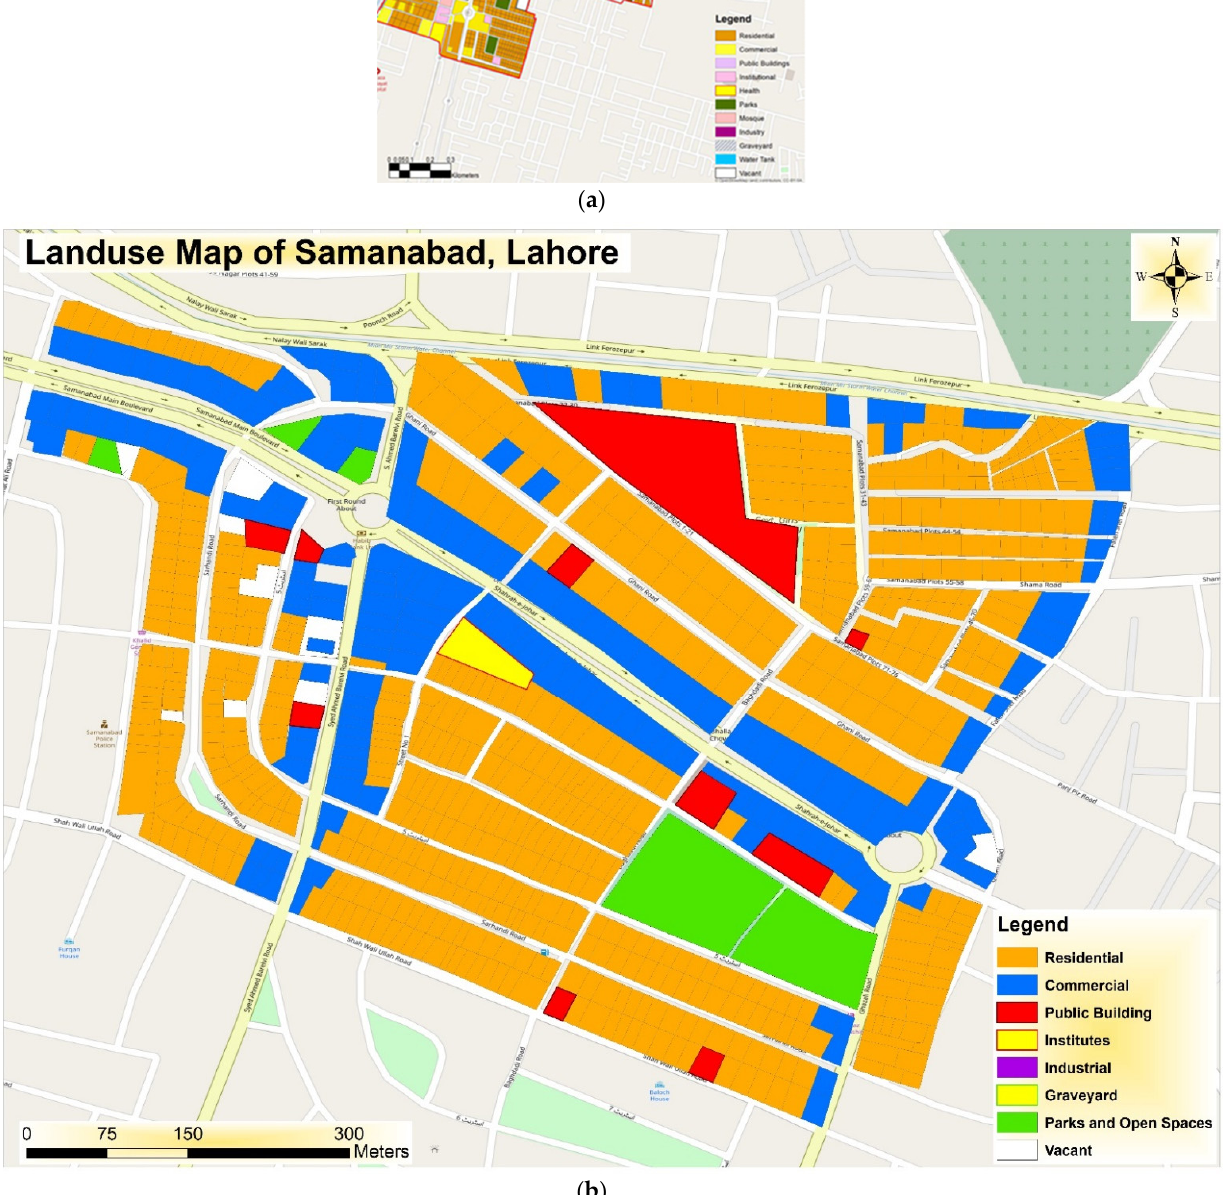
Figure 1. The two selected neighborhoods in Lahore( a ) Pak Arab, as a sprawled neighborhood; ( b ) Samanabad, as a compact neighborhood, by authors; adapted from Google Earth, 2021.